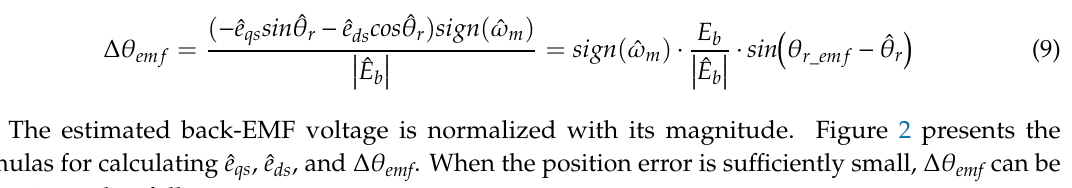
Figure 3. Rotor position and speed estimator.